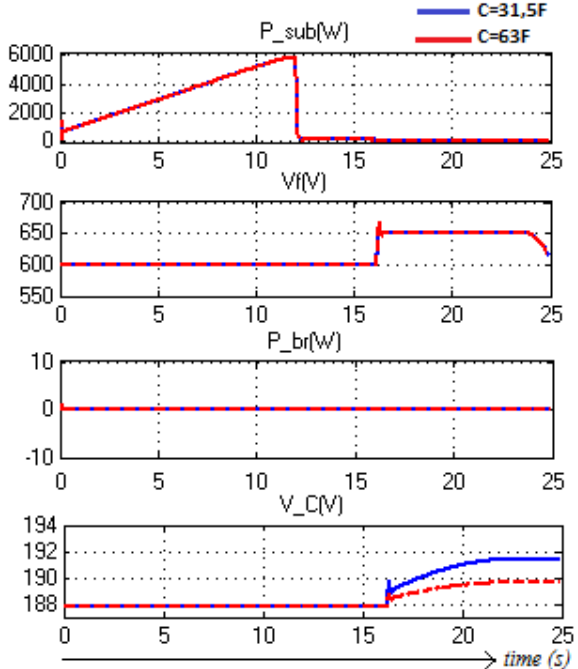
Fig. 8. Simulation diagrams for V SC = 187.83 V for both C = 31.5 F and C = 63 F.